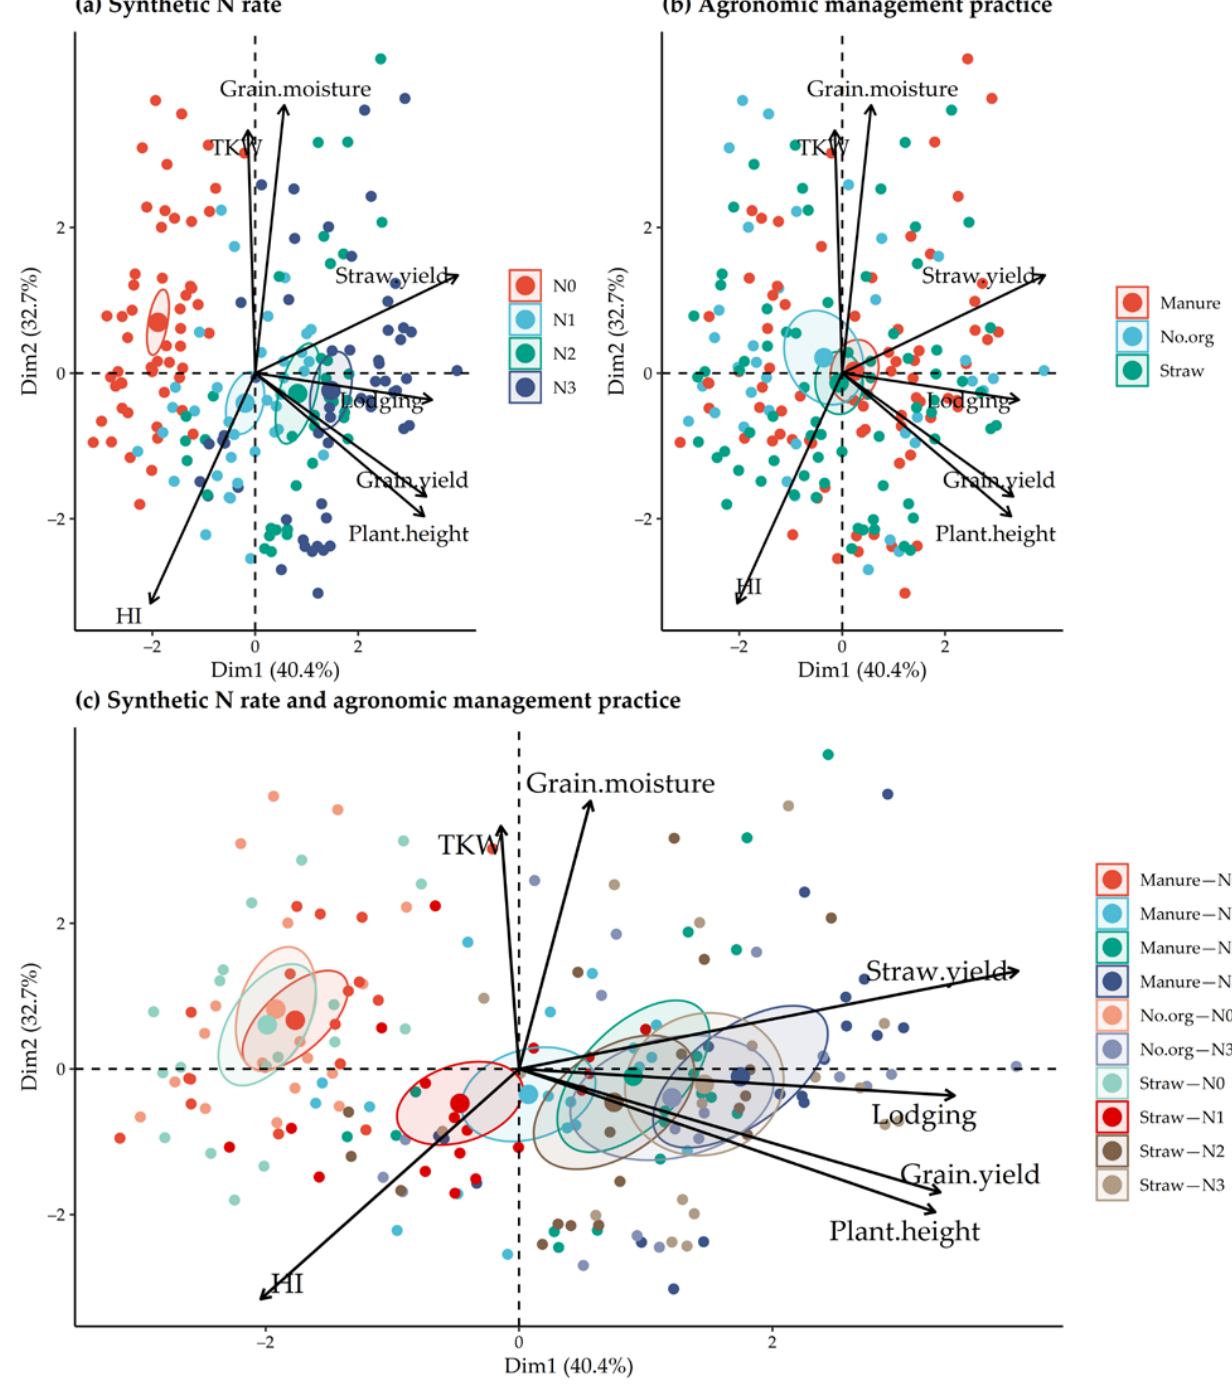
Figure 5. PCA analysis score plots ( a – c ) of oat agronomic performance traits (grain and straw yield, grain moisture, plant height, plant lodging, TKW and HI) during 2015–2020 as a function of applied N rate and agronomic management practices of the long-term field experiment for the first and second principal components. The ellipses represent 95% confidence intervals.